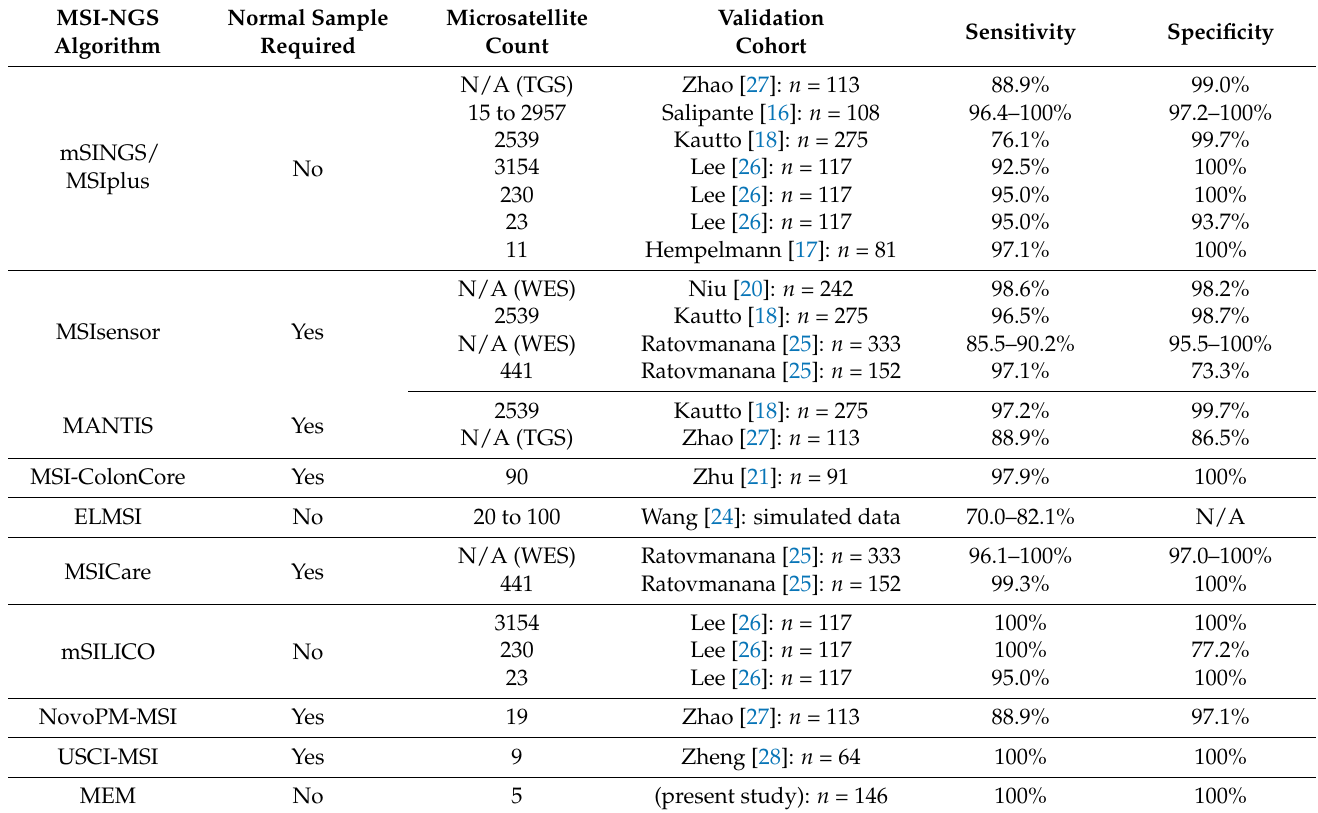
Table 5. Reported diagnostic performances for the main MSI-NGS algorithms for the determination of MSI status, consider- ing MSI-PCR as